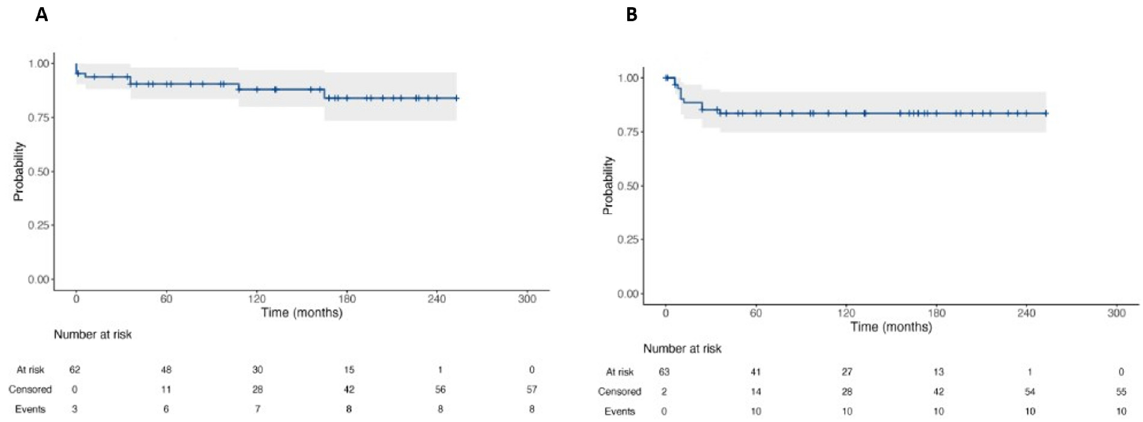
Figure 6. Kaplan–Meier Curve for Overall Survival ( A ) and Recurrence-Free Survival ( B ) of patients with testicular cancer and submitted to RPLND.